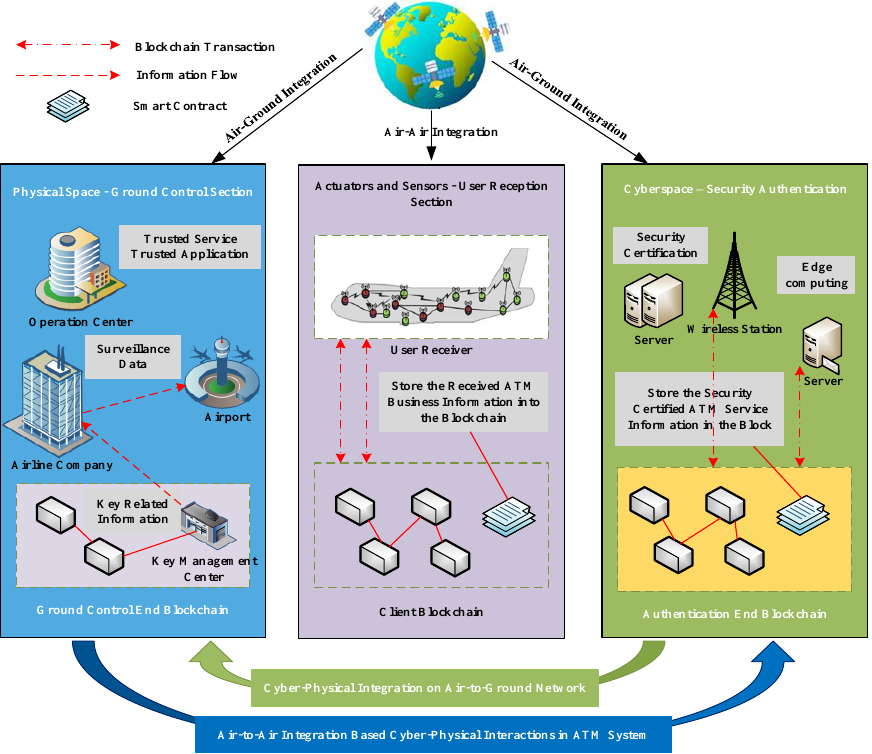
Figure 11. Information security assurance architecture of networked ATM system based on trust- worthy